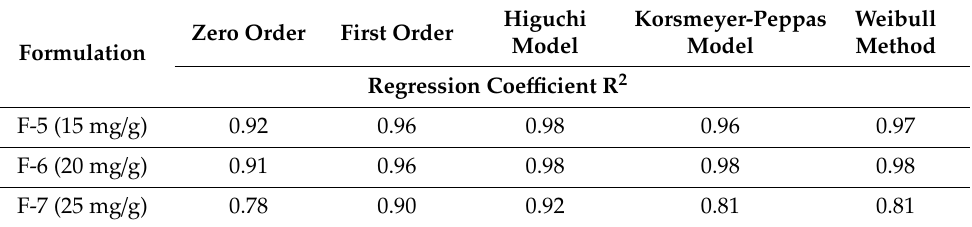
Table 6. In vitro drug release rate ang goodness of fit of ACTH ointments using Higuchi’s model ( n = 6); *— p <